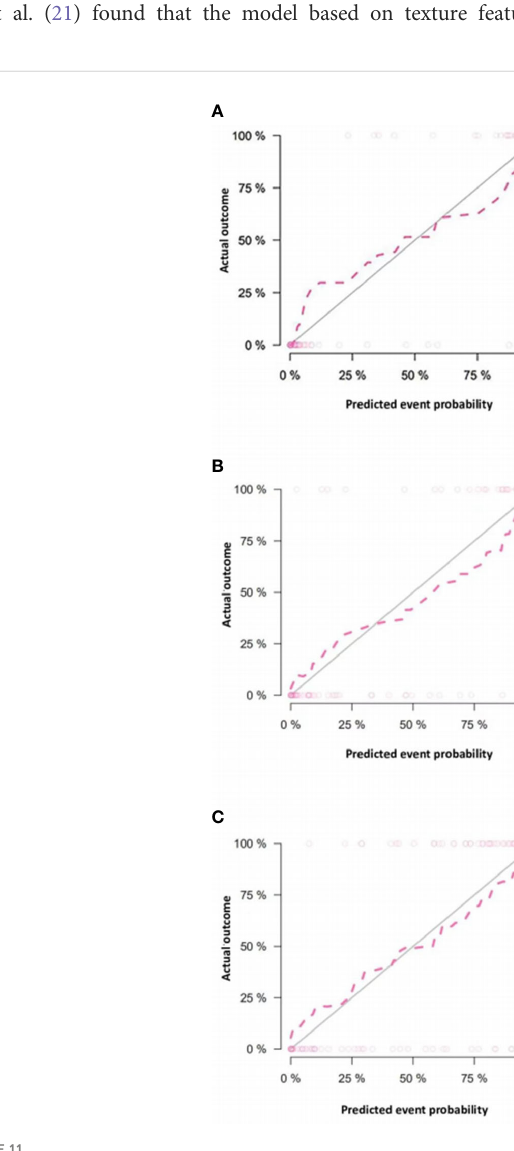
FIGURE 11 Calibration curves of the nomograms in the training group and test group of models 1, 2 and 4. ( A are the training group and test group of model 1, respectively; B are the training group and test group of model 2; and C are the training group and test group of model 4) In the calibration curve, the horizontal axis represents the predicted model value, and the vertical axis represents the real value. The prediction ef fi cacy is better if the red line is closer to the gray